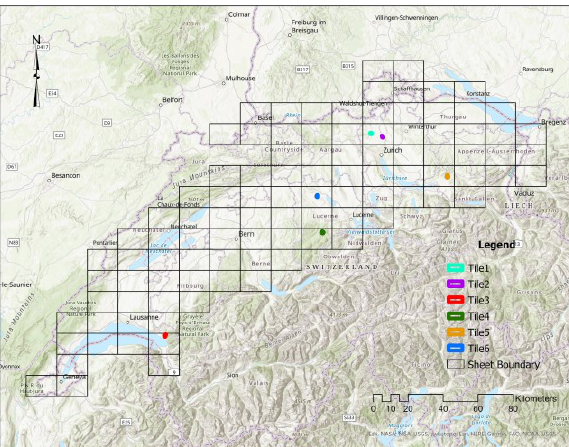
Figure 1. Extent of the study area and the location of the selected tiles for experimental analysis.